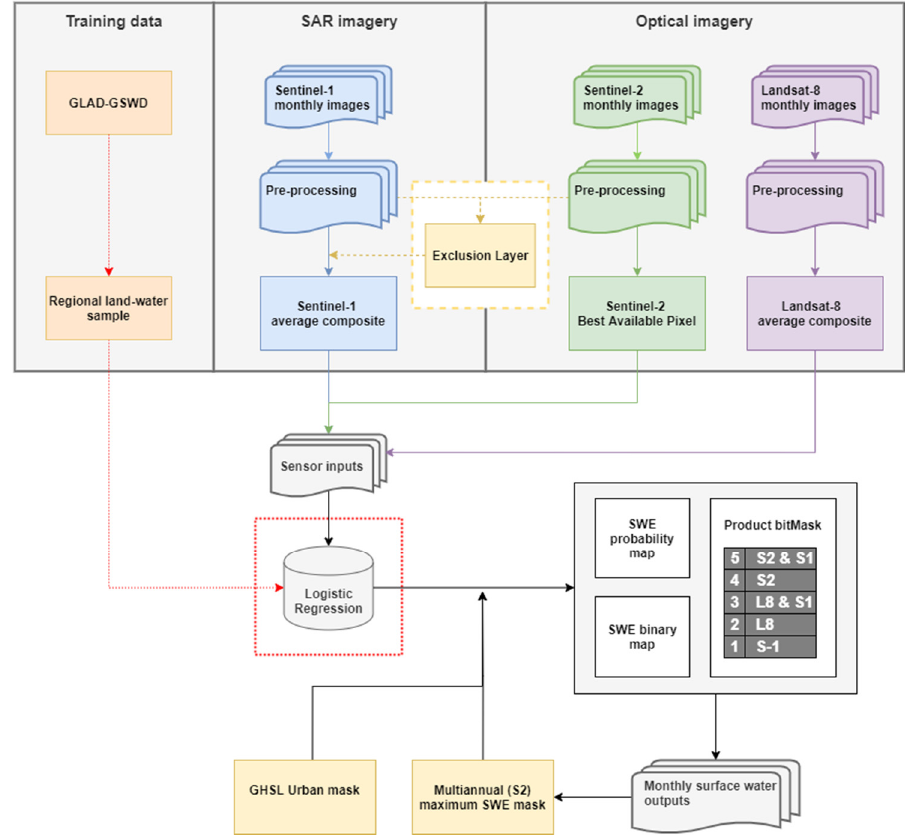
Figure 1. Schematic illustration of the classification workflow.